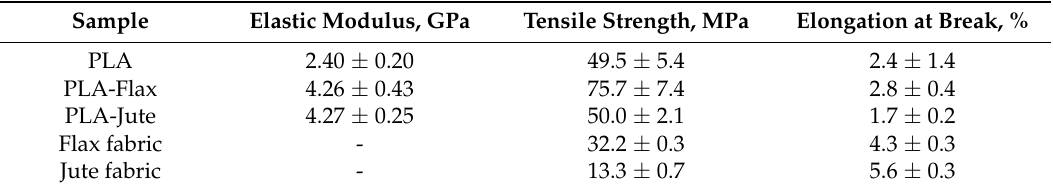
Table 1. Tensile properties of the investigated composites and